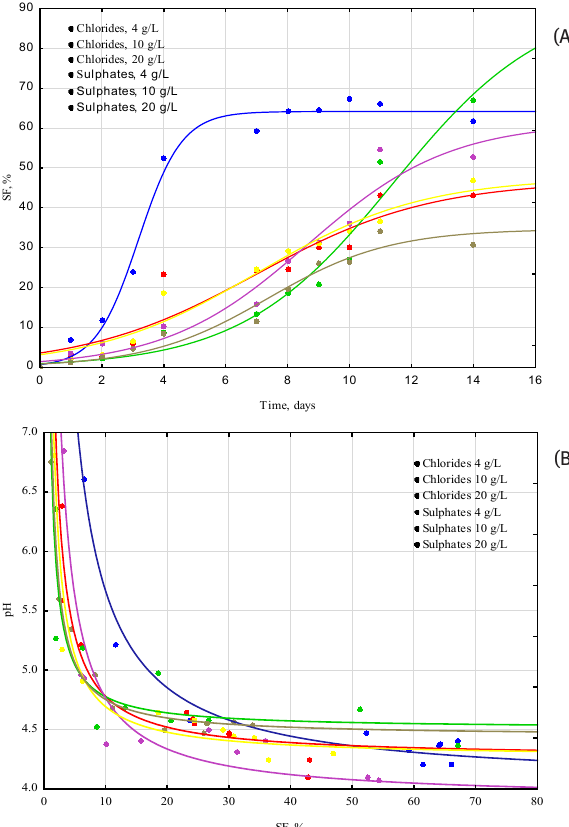
Figure 2: Changing the Solubilization Factor of phosphates A) in time and B) in relationship to the SF and pH.